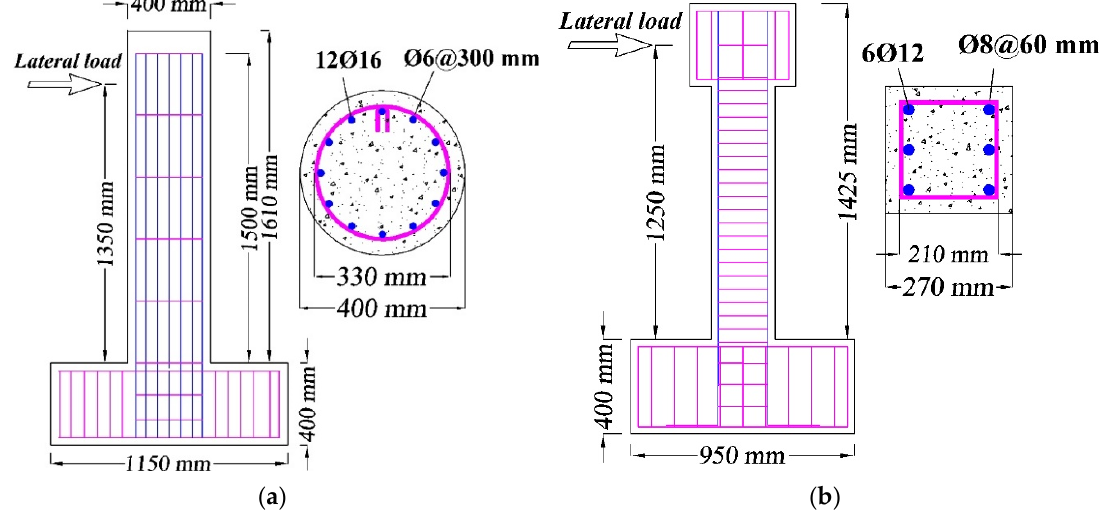
Figure 2. Schematic of geometry and reinforcement details of two selected columns: ( a ) Kawashima et al. column [45]; ( b ) Ding et al. column [15].